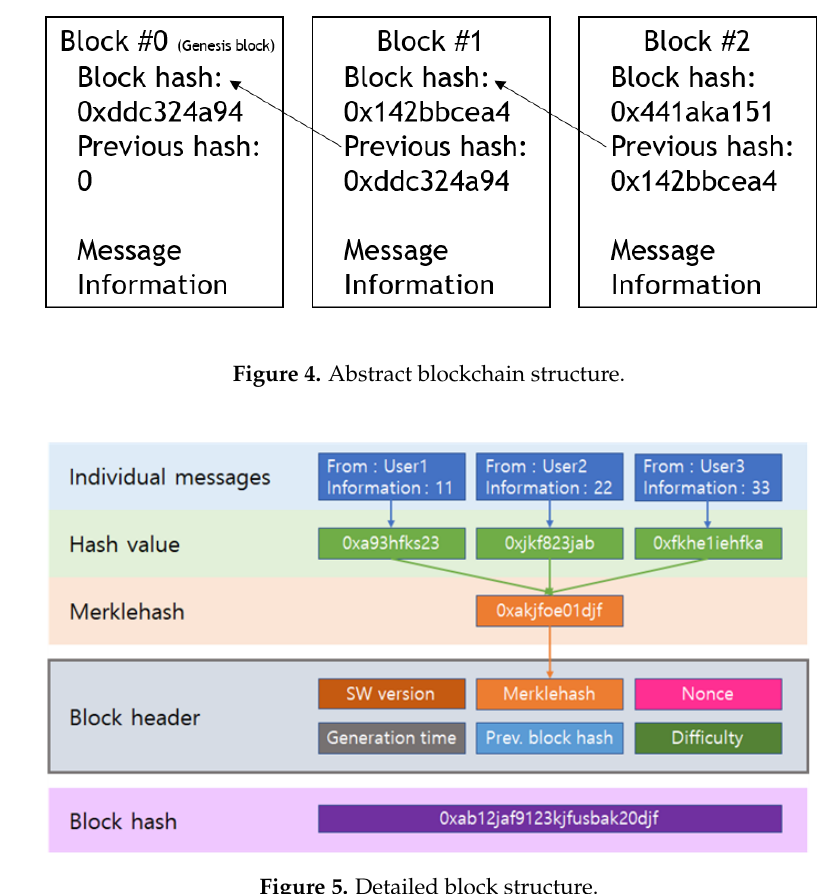
Figure 5. Detailed block